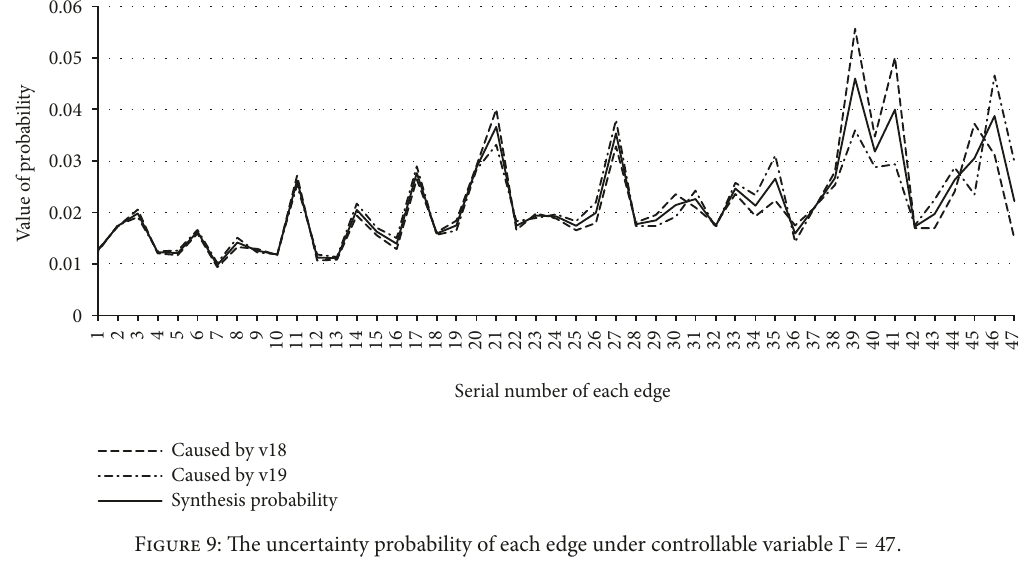
Figure 9: The uncertainty probability of each edge under controllable variable Γ = 47 .